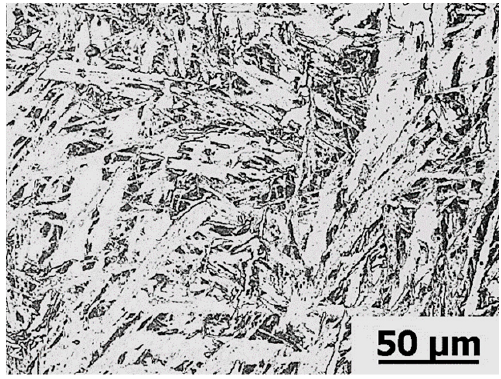
Figure 12. Ingot microstructure of industrial test steel.